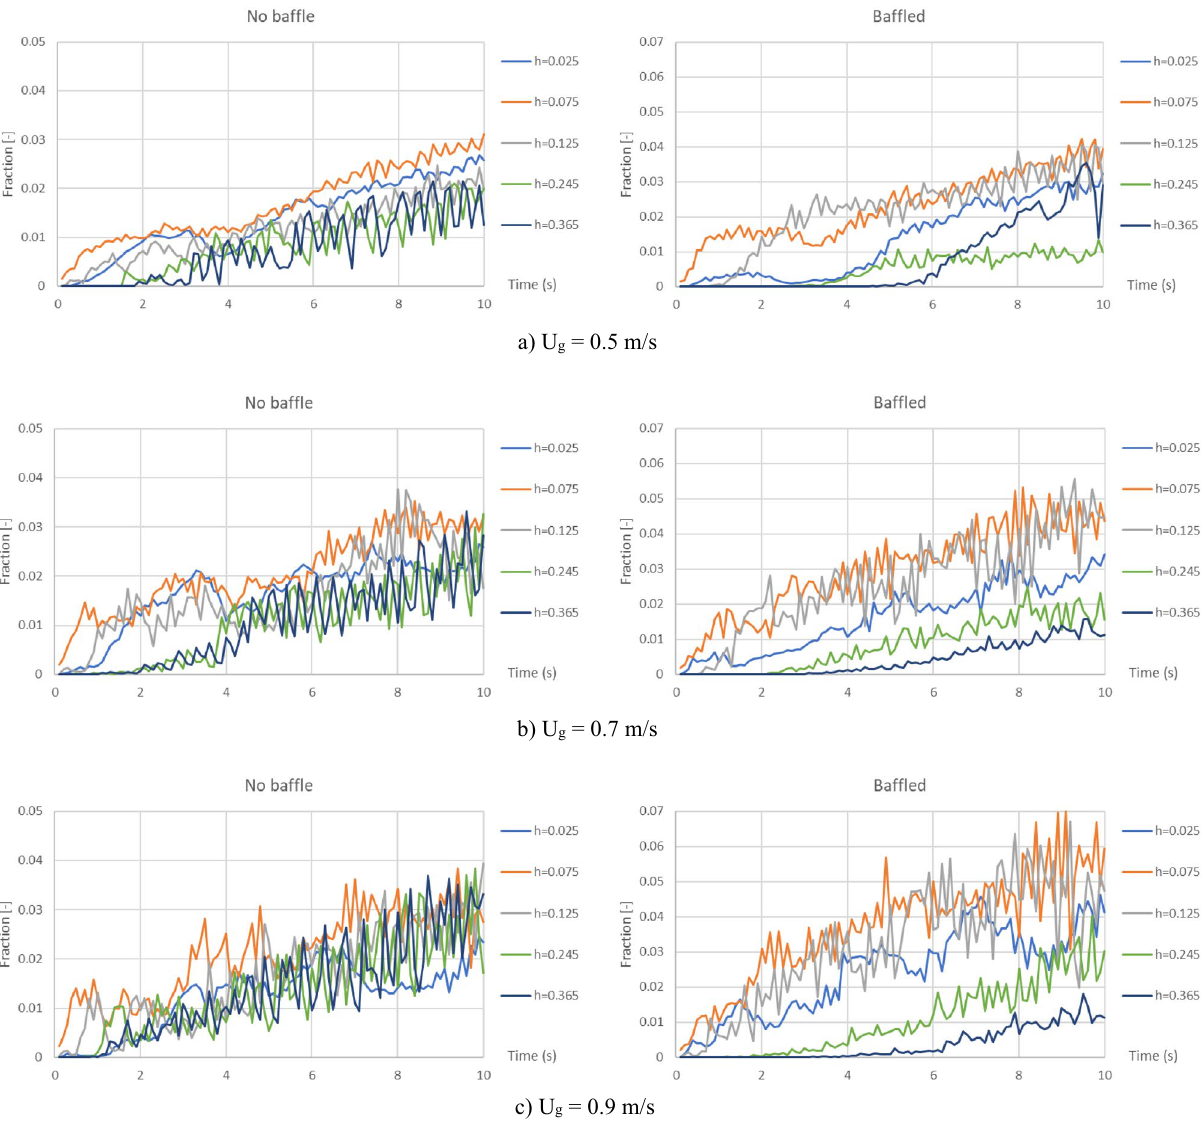
Figure 5. Area-averaged biomass fraction as a function of time at different heights inside the no-baffle gasifier (left) and the baffled gasifier (right), when operating at various gas inlet